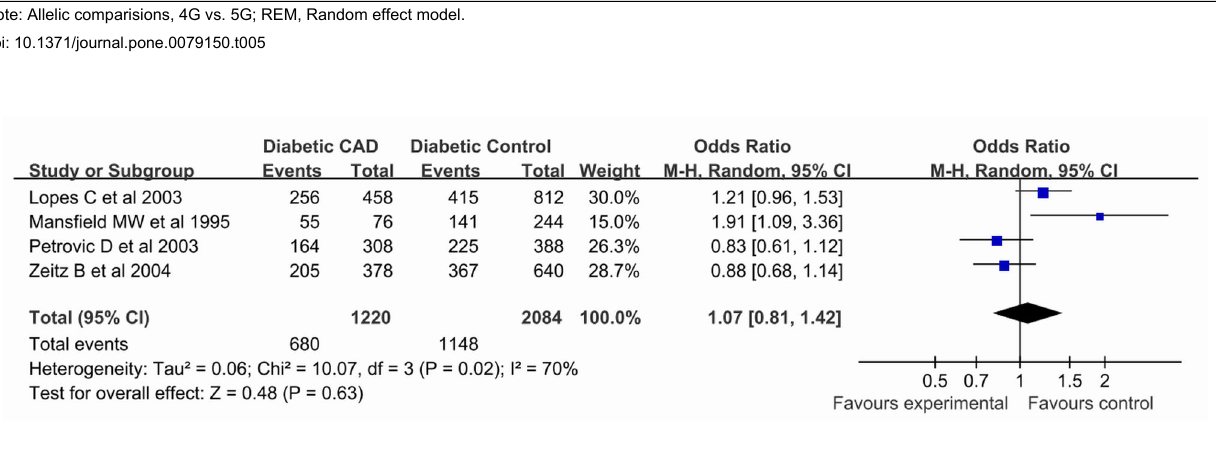
Figure 4. Pooled ORs for the association between the PAI-1 -675 4G/5G polymorphism (4G vs. 5G) and susceptibility to diabetic coronary artery disease. The area of the squares reflects the study-specific weight. The diamond shows the summary random-effects OR estimate from 4